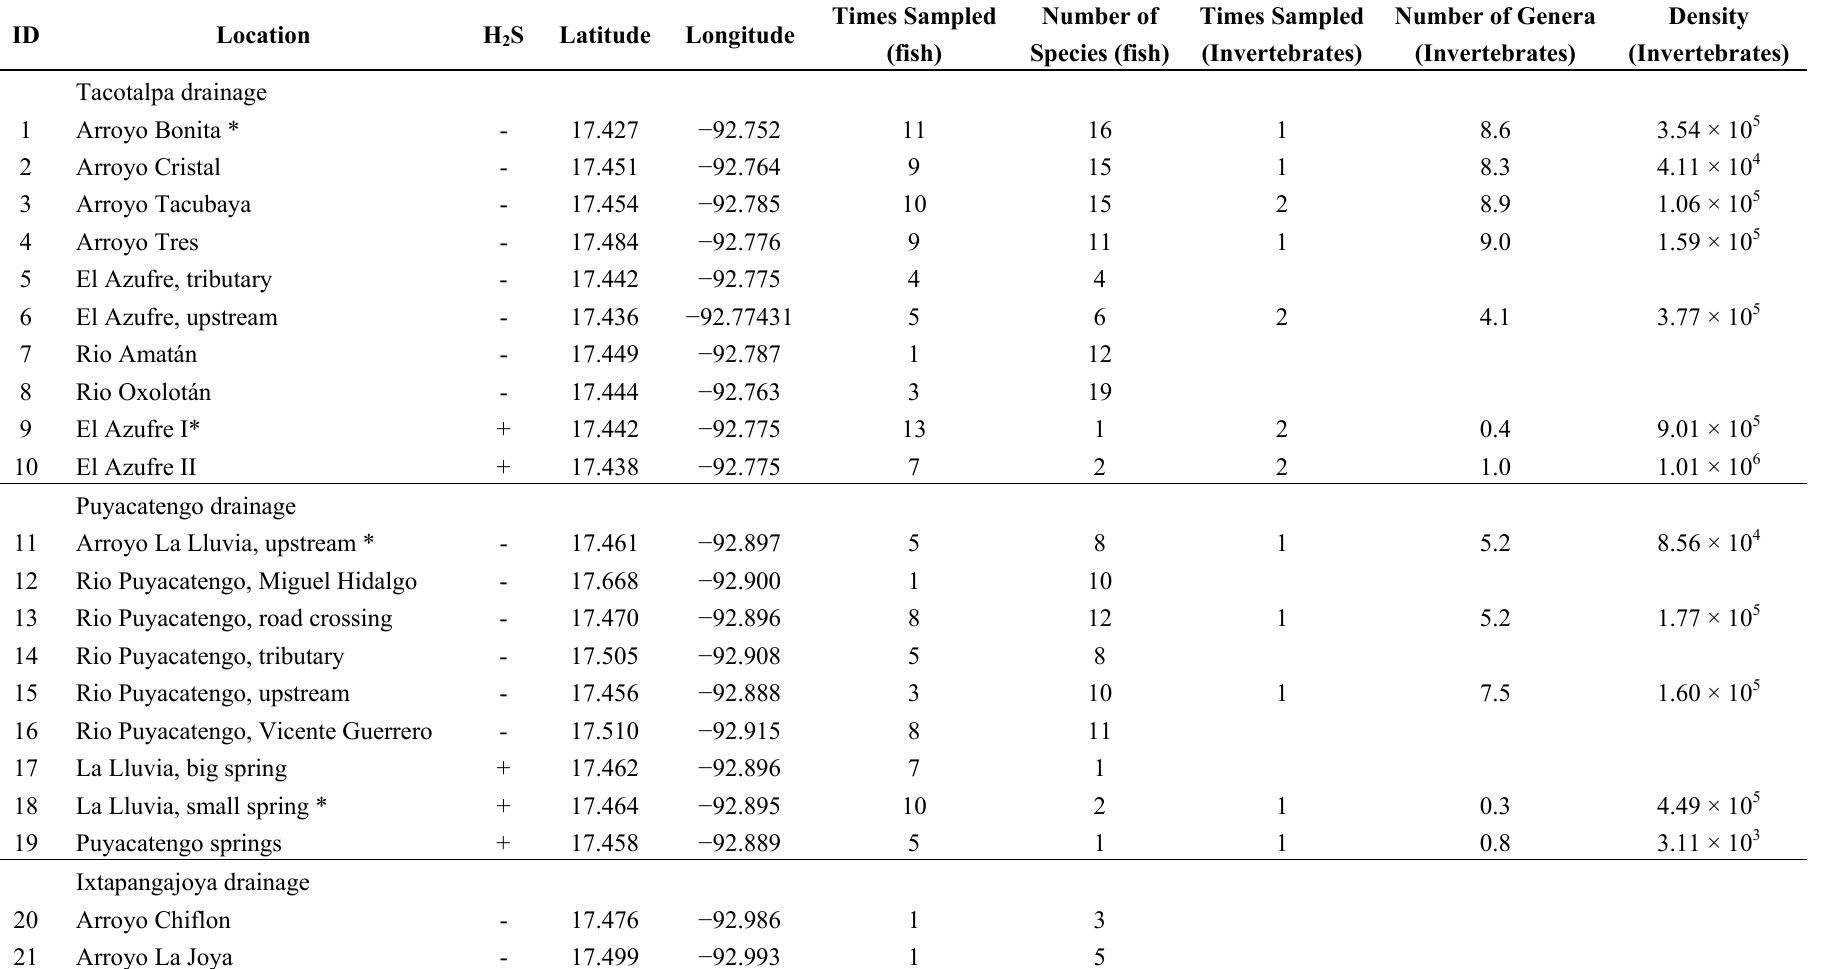
Table 2. Sites investigated for the case study comparing diversity patterns between sulphidic and adjacent, non-sulphidic habitats in southern Mexico. Provided are locality information, summary statistics of fish communities (number of times sampled for qualitative surveys and cumulative number of species recorded) and invertebrate communities (number of times sampled, average number of genera per m 2 , and density per m 2